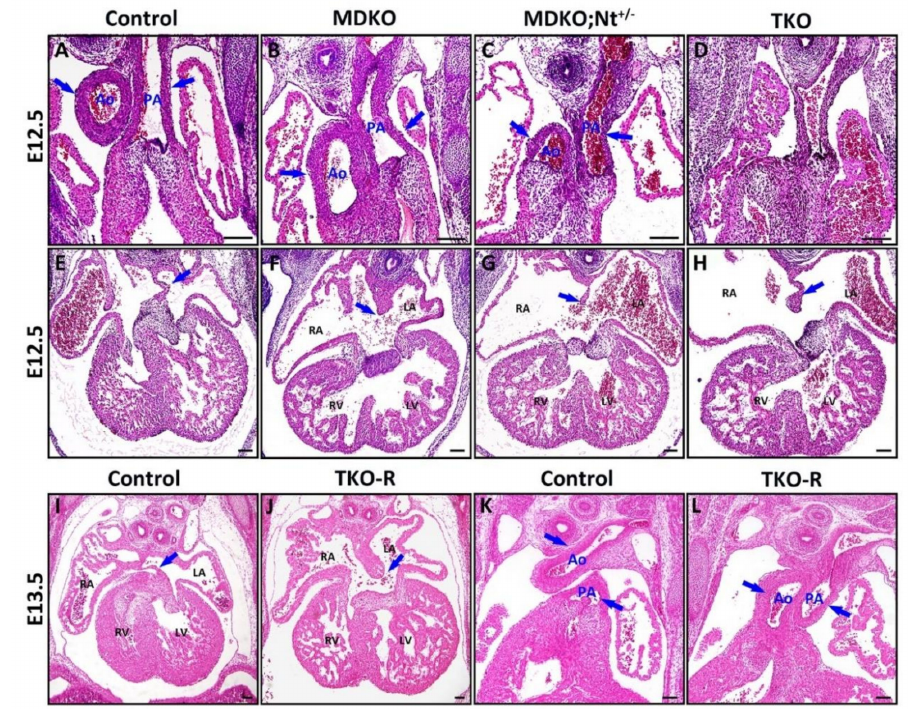
Figure 4. Notch1 or RBPJk deletion in MDKO did not rescue the structural defects of MDKO. ( A – H ) The morphologies of Control, MDKO, MDKO; Nt1 +/ − , and TKO were examined via H&E staining at E12.5. Both MDKO and TKO display OFT alignment and septation defects of ( A – D ) and atrioventricular septation defect (AVSD) ( E – H ) (n = 5). ( I – L ) Numb , Numbl and RBPJk triple knockout (TKO-R) hearts display AVSD and OFT alignment and septation defect (N = 5). The blue arrows indicate aorta (Ao), pulmonary artery (PA) or atrial septum. Scale bars: 200 µ